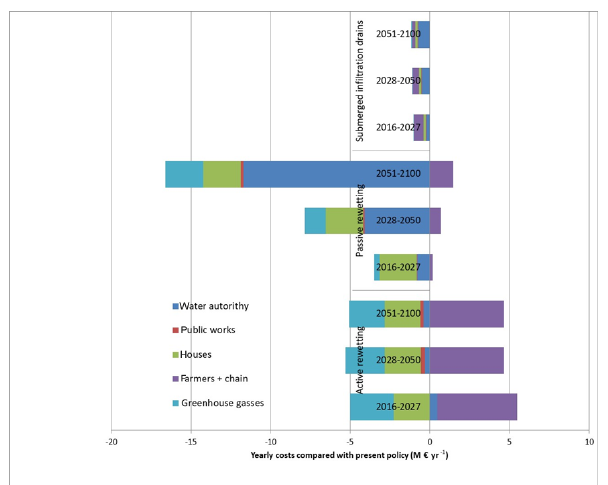
Figure 3. Average differences in yearly costs (EUR million per year) in each period in each of the 3 scenarios, compared with present